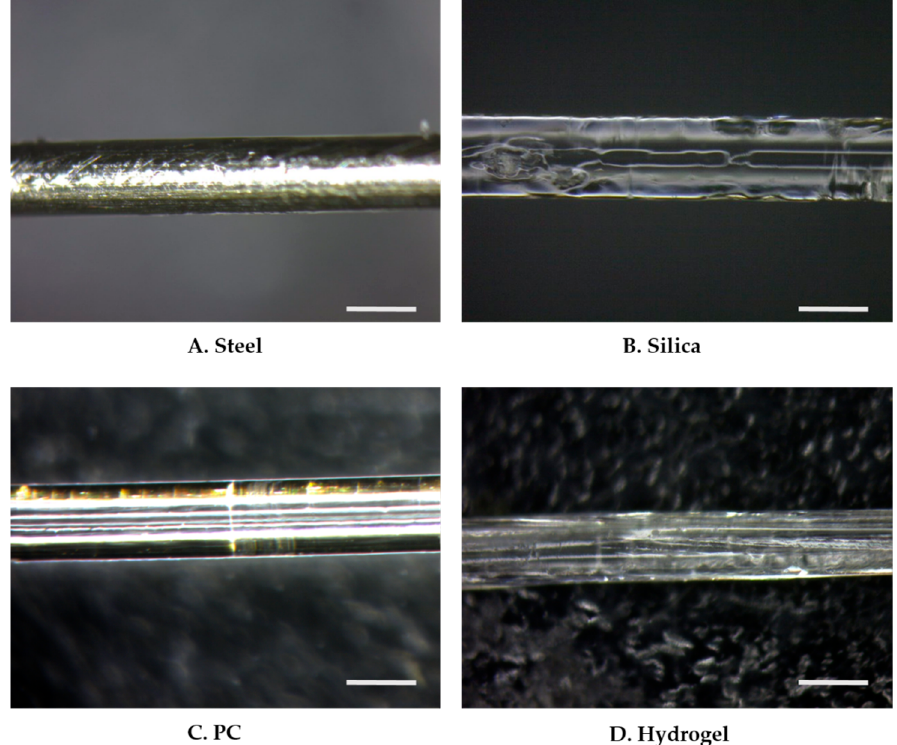
Figure 2. Microscope images of PDMS dip-coated thermally drawn fibers of ( A ) stainless steel (steel), ( B ) silica, ( C ) PC, and ( D ) HydroMed D4 (hydrogel). The scale bar indicates 400 μ m.